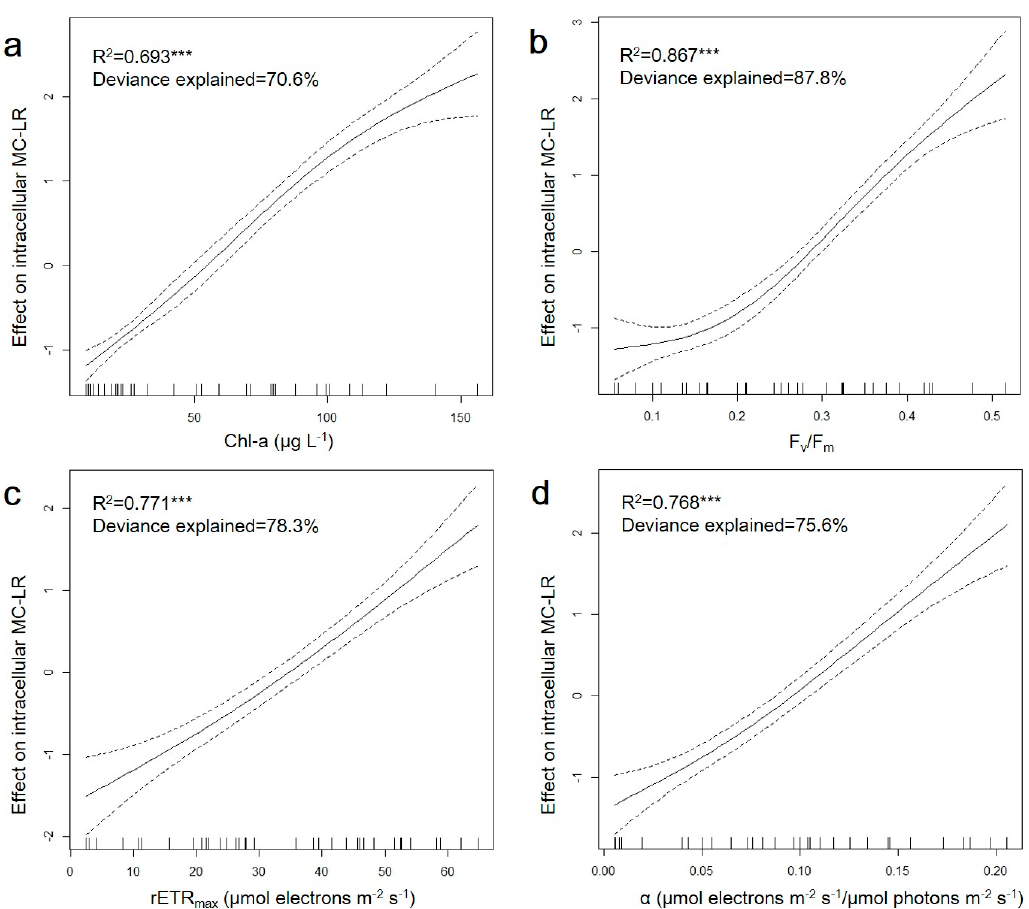
Figure 5. Chl- a (chlorophyll- a ) ( a ), F v /F m ( b ), rETR max ( c ) and α ( d ) effect curves from a GAM model fitted to intracellular MC–LR concentration data (solid lines), with two 95% confidence bands (dashed lines). R 2 , significance level and explained deviation are indicated; *** p < 0.001.